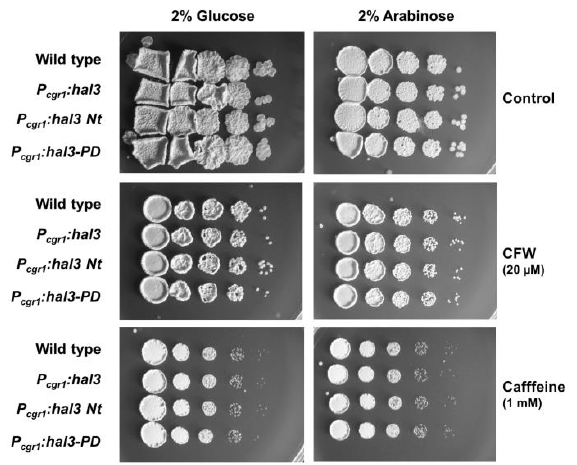
Figure 8. Growth of U. maydis strains overexpressing full-length UmHal3 and its N-terminal and C-terminal regions. Cells were grown in YPD and ten-fold dilutions of this culture were spotted on CMD (2% glucose, repressing conditions) or CMA (2% arabinose, de-repressing conditions) plates with the indicated chemicals. Pictures were taken after two days incubation at 28°C.